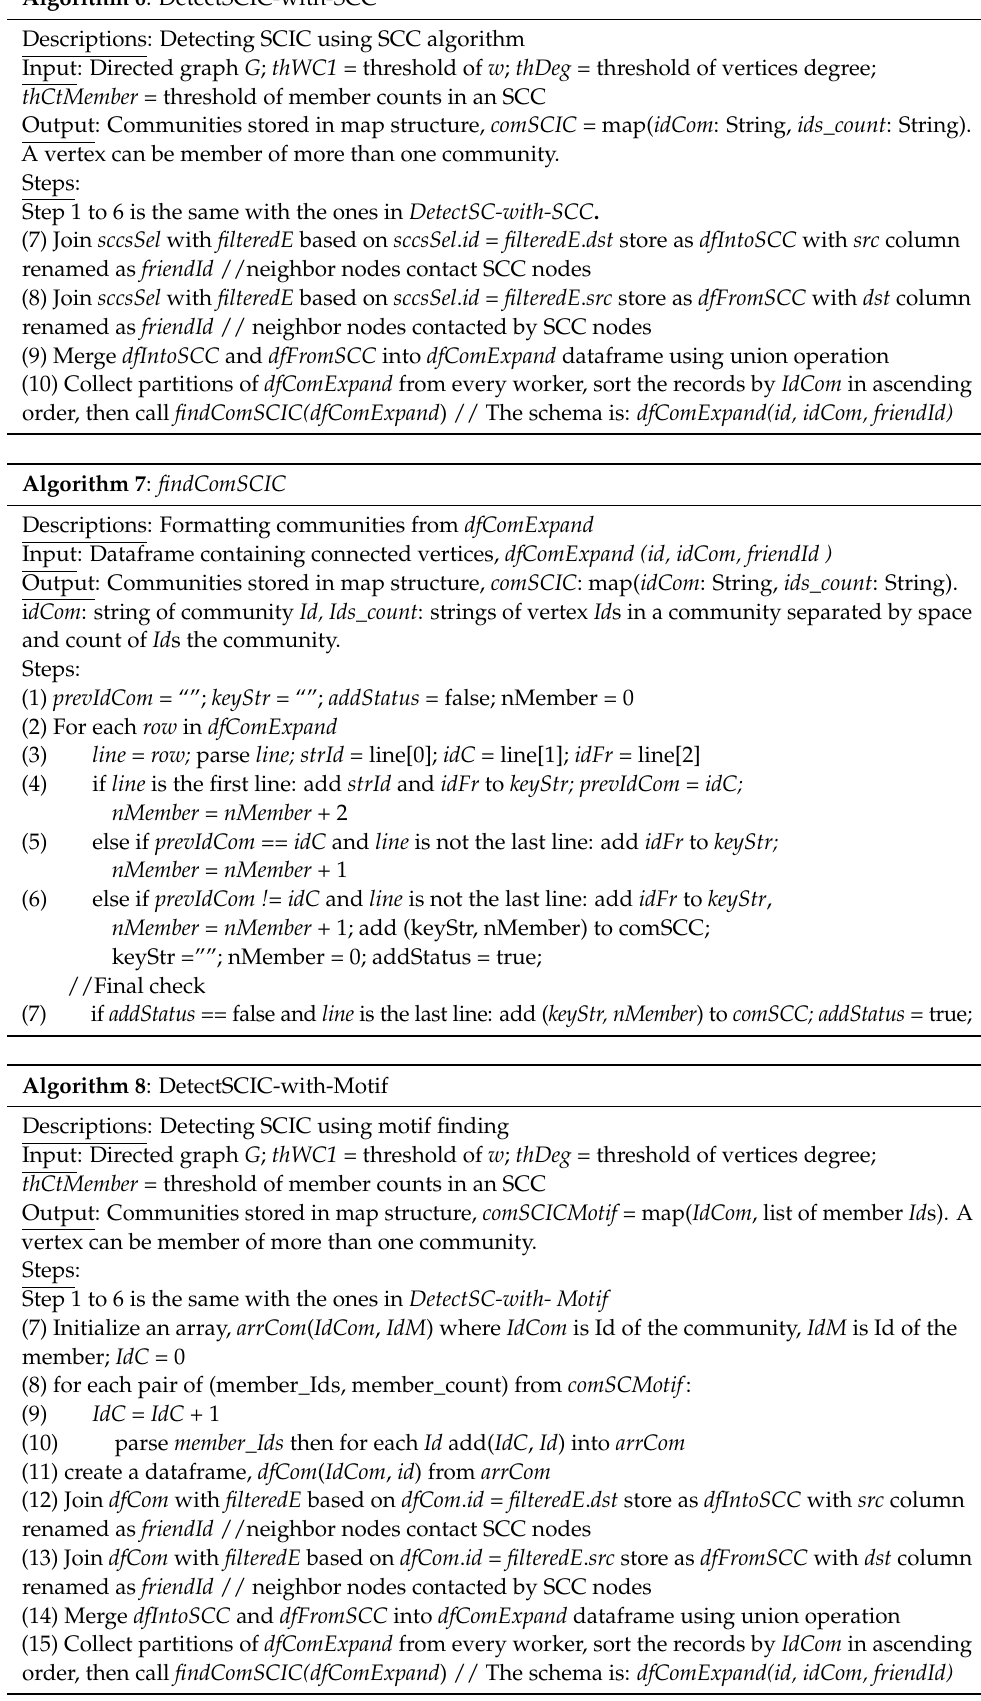
Algorithm 6 : DetectSCIC-with-SCC Descriptions: Detecting SCIC using SCC algorithm